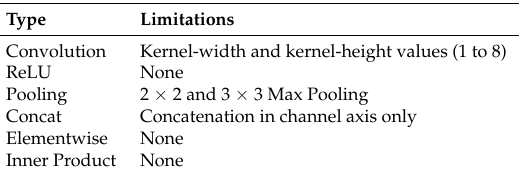
Table 2. Operations Supported by Xilinx